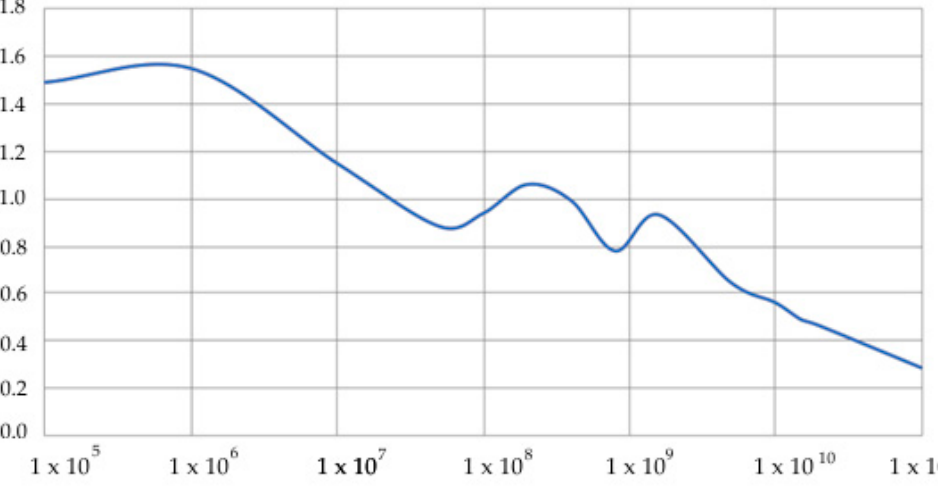
Figure 7. Dependence C ( E i , ρ i , h i ) on the modulus of elasticity of the immersion layer E 3 , Pa, h 4 = ρ